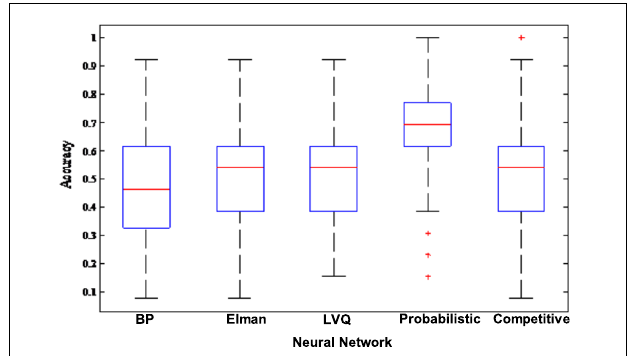
FIGURE 4 | The corresponding 1,000 NNs’ accuracies of five types of random neural network clusters.